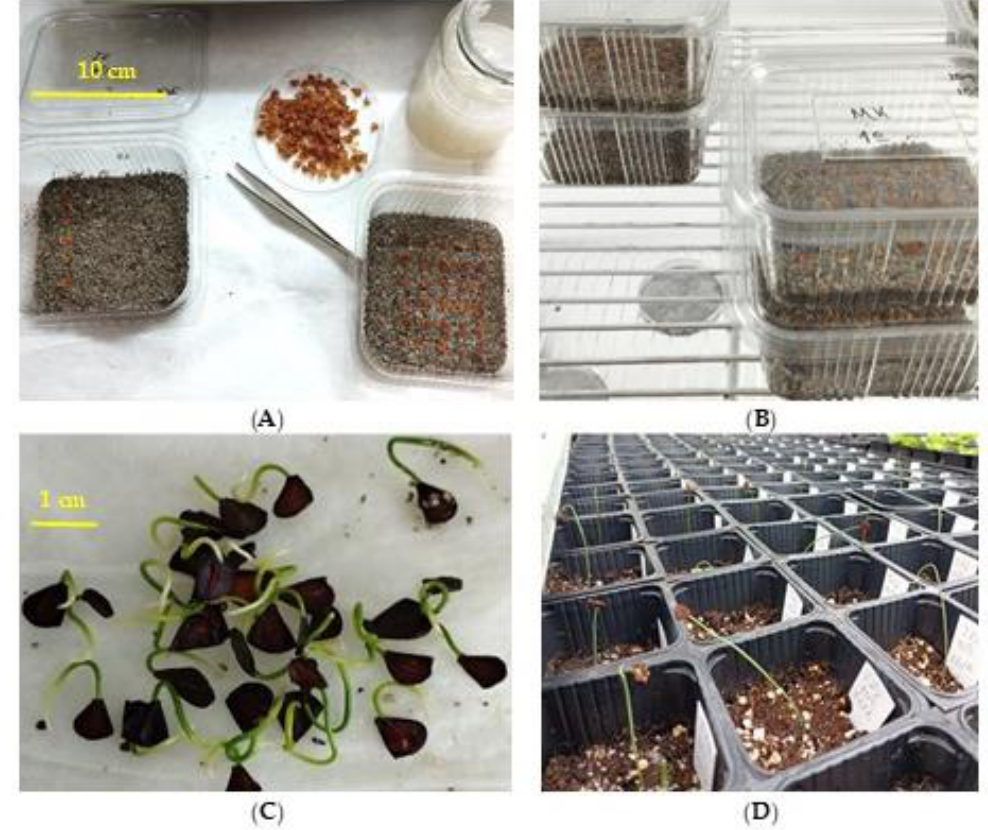
Figure 10. ( A ) Sowing of wild-growing Greek tulip seeds in plastic boxes with disinfected sand consequently placed in a growth chamber ( B ); ( C ) germinated seeds of the vulnerable Balkan subendemic Tulipa undulatifolia ; ( D ) seedlings of the vulnerable Greek endemic Tulipa goulimyi growing in plastic pots in a greenhouse 30 days after germination.